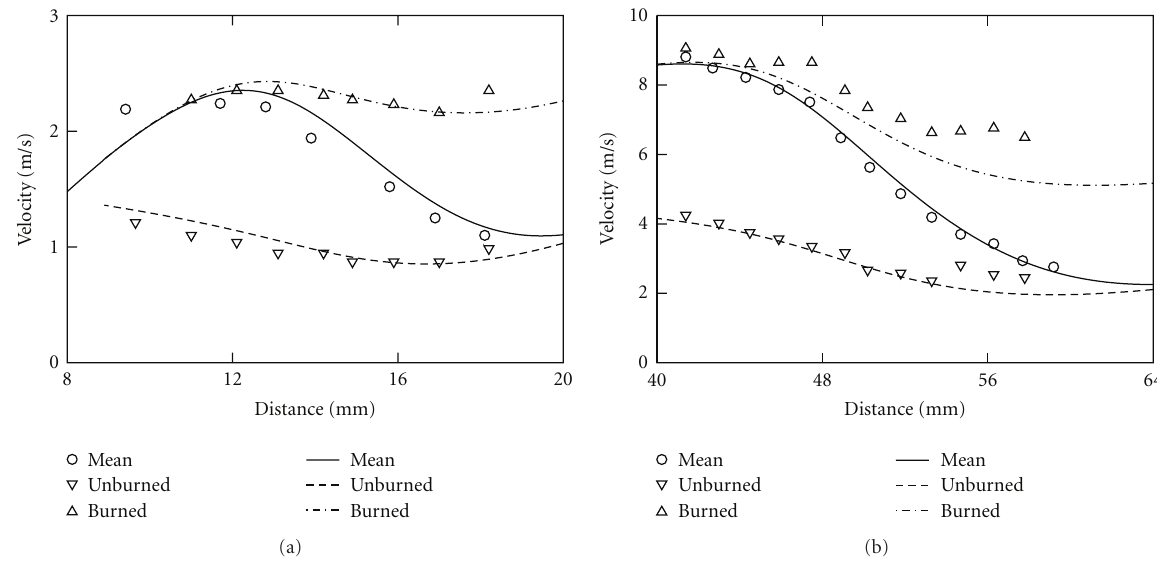
Figure 3: Axial profiles of the Reynolds-averaged and conditioned axial velocities in the flames investigated by Cho et al. [15] (a) and by Cheng and Shepherd [16] (b). Symbols show experimental data. Curves have been computed.